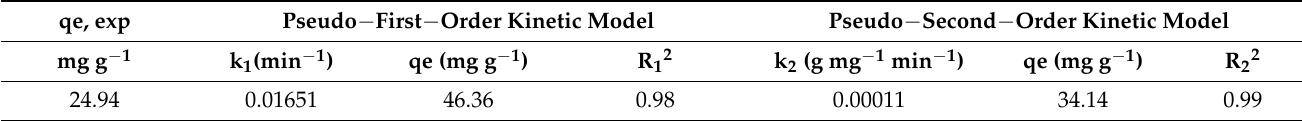
Figure 7. Diagram of ( a ) pseudo − first − order kinetic model and ( b ) pseudo − second − order kinetic model for the adsorption of Cl − on the LDO; ( c ) Langmuir model and ( d ) Freundlich model for the adsorption of Cl − on the LDO. Table 3. Pseudo-first-order and pseudo-second-order kinetic model parameters.